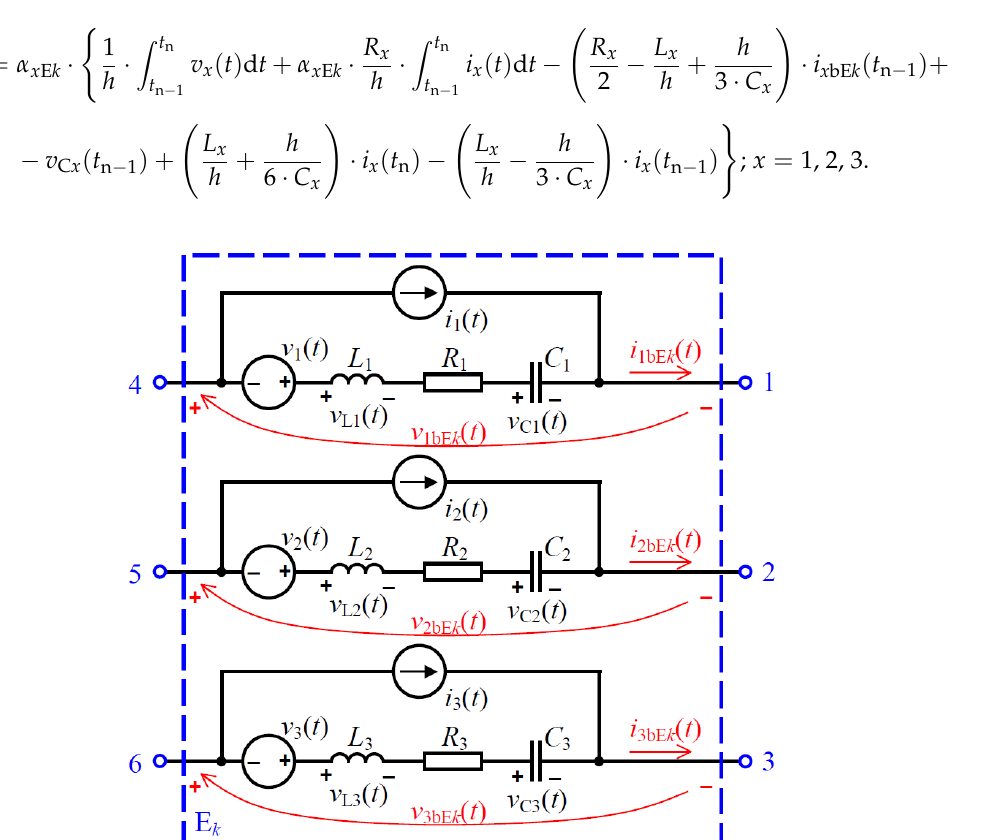
Figure 7. Structural element that reflects the three-phase element consisting of generalized linear